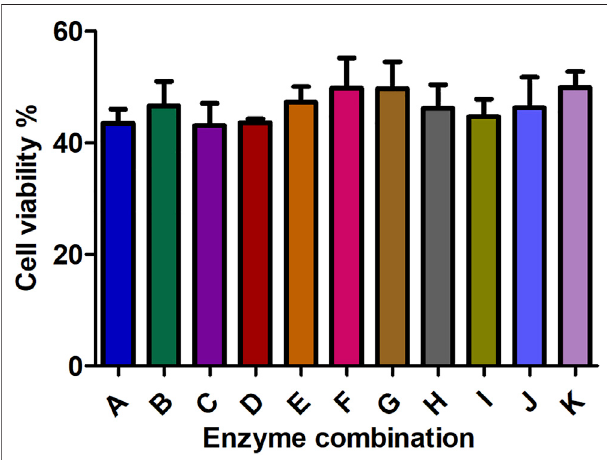
FIGURE 5 | The effect of different enzyme combinations on cell viability during kidney tissue digestion. Data are presented as means ± SD; ns p value = 0.2953.